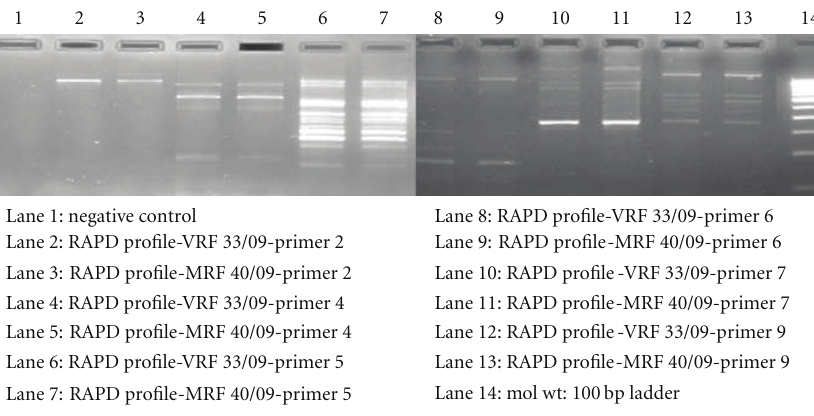
Figure 2: Representative results of random amplification of polymorphic DNA finger printing profiles of Salmonella typhi isolated from blood culture and eviscerated material by RAPD PCR using primers 2, 4, 5, 6, 7, and